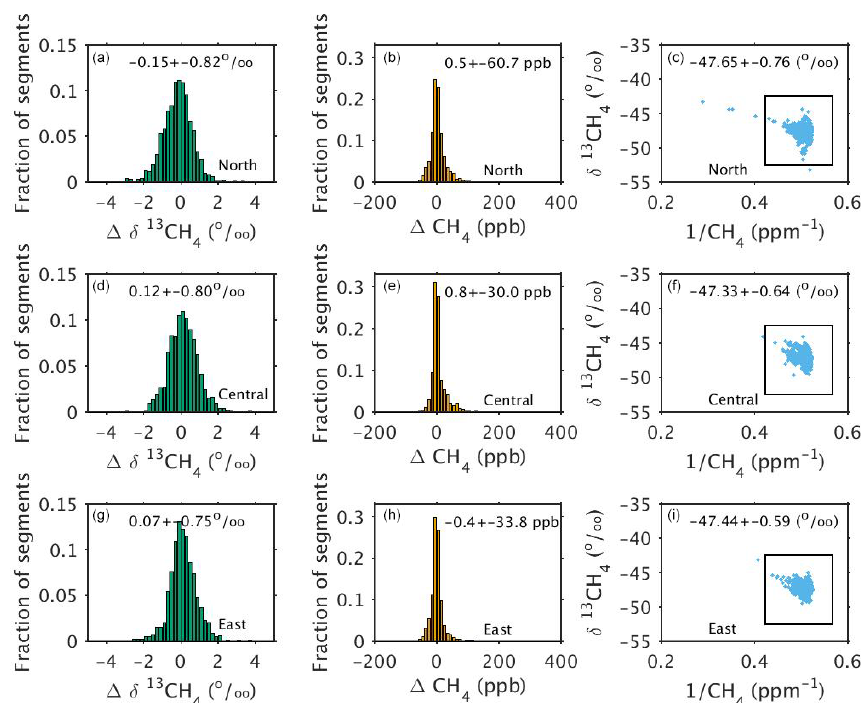
Figure 14. Probability distribution function of measured isotopic ratio differences from the background south tower ( (cid:49)δ 13 CH 4 ) for the (a) north, (d) central, and (g) east towers for afternoon hours (17:00–20:59UTC, 12:00–15:59LST). The averaging interval of the individual data points for all plots is 10min, and the time period is January–May 2016. The bin size for (a) , (d) , and (g) is 0.2‰. The median and standard deviation of the differences are indicated on the plots. Probability distribution function of measured methane mole fraction enhancements ( (cid:49) CH 4 ) for the (b) north, (e) central, and (h) east towers. Note that the scale for (b) , (e) , and (h) has been truncated to focus on majority of the data points. The bin size is 10ppb CH 4 . Keeling plots for the (c) north, (f) central, and (i) east towers. The black box in each plot indicates the approximate scale of the corresponding isotopic ratio difference and methane mole fraction enhancement plots. The median and standard deviation of the isotopic ratios at each tower are indicated on the plots. Note that the Allan deviation for 10min means at ambient mole fractions was 0.4‰, and this decreases with increasing mole